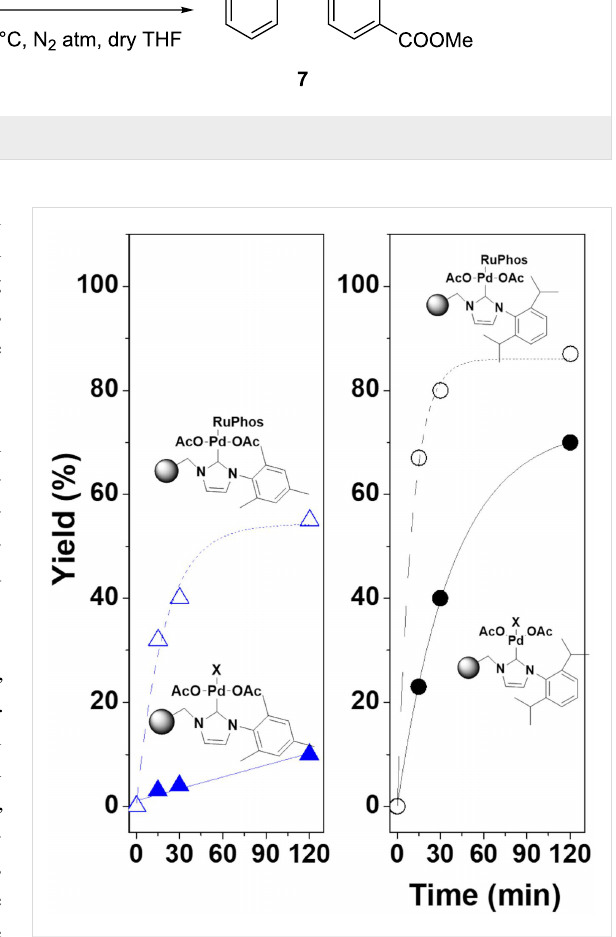
Figure 1: Negishi reaction catalyzed by immobilized NHC–Pd com- plexes. Conditions: methyl 4-bromobenzoate (0.25 mmol, 1 equiv), benzylzinc bromide (0.5 mmol, 2 equiv, 1 mL of a 0.5 M solution in THF), 5 mol % of Pd catalyst (0.0125 mmol) in dry THF (1 mL). N 2 at- mosphere, 60 °C. Yields calculated by GC and confirmed by 1 H NMR.